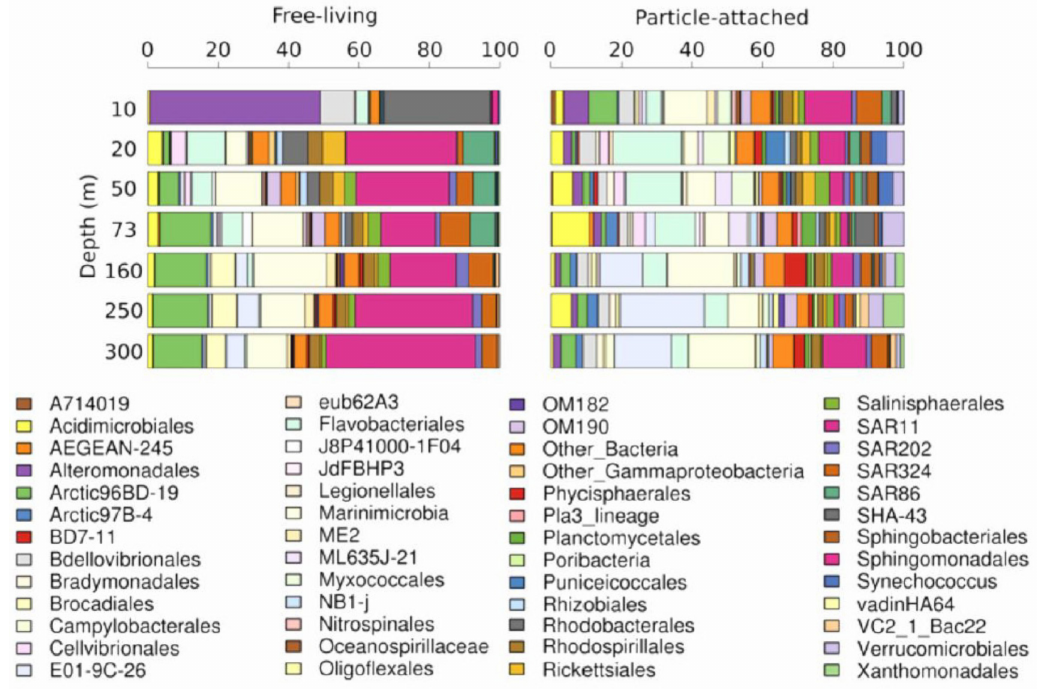
Figure 3. Relative abundance of the most abundant taxa (above 1%) in at least one sampling point at T5 station for two fraction sizes (free-living and particle